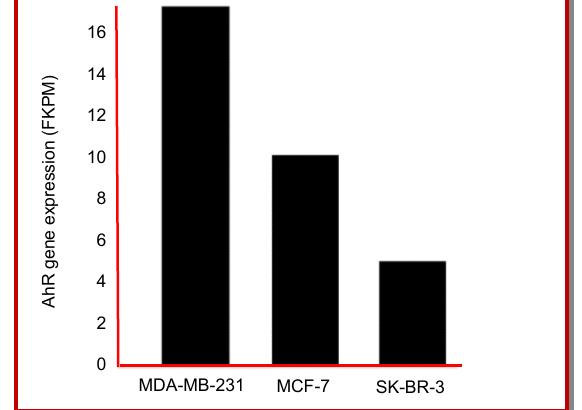
Figure 2: AhR gene expression profile in MDA-MB-231, MCF- 7, and SK-BR-3 human breast cancer cell lines. AhR expression data were taken from the ebi. ac.UK database. FKPM: Frag- ments per kilobase of exon model per million reads